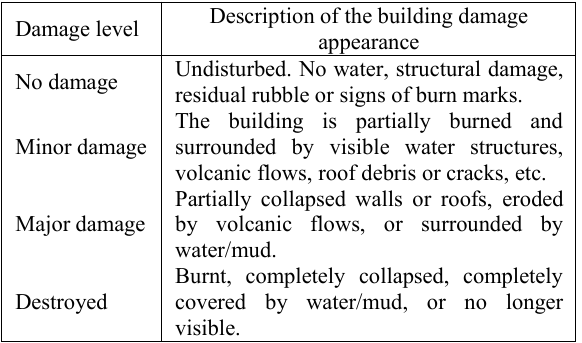
Table 1 . Building damage level and appearance description